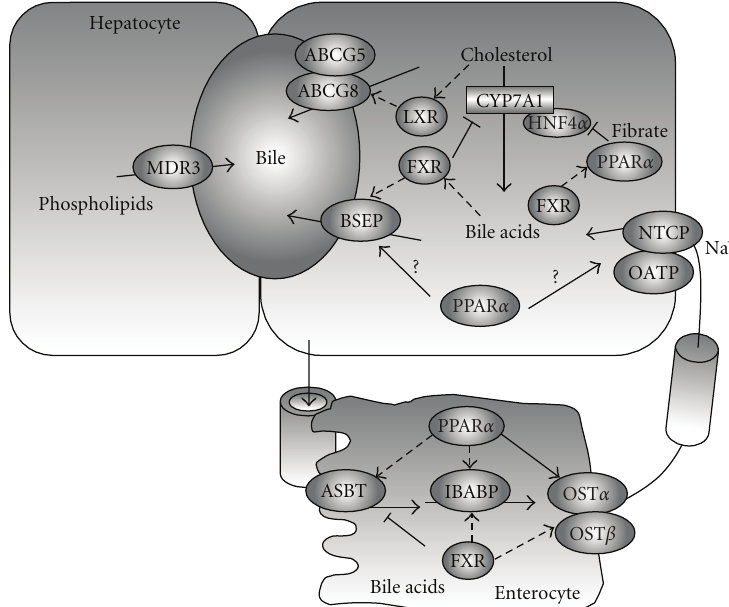
Figure 2: Enterohepatic circulation of bile. Bile acids are transported across the canalicular membrane of hepatocytes by BSEP. Cholesterol is either converted into bile acids for biliary secretion or transported by ABCG5/G8 into the bile. MDR3 mediates biliary phospolipids secretion. Cholesterol, bile acids and phospholipids form mixed micelles to solublize cholesterol and reduce bile acid cytotoxicity. After food intake, gallbladder contracts and releases bile acids into intestine. Approximately 95% of bile acids are reabsorbed into the enterocytes. OST α /OST β heterodimeric transporter mediates basolateral bile acid e ffl ux into the portal circulation. NTCP and OATPs mediate hepatic basolateral uptake of bile acids, which are then resecreted into the bile. In the hepatocytes, bile acid-activated FXR feedback inhibits CYP7A1 and NTCP, and thus bile acid synthesis and uptake. Bile acid-activated feed-forward stimulates BSEP and biliary bile acid secretion. Cholesterol derivatives oxysterols activate LXR, which induces ABCG5/G8 and biliary cholesterol secretion. In the intestine, FXR inhibits ASBT and stimulates IBABP and OST α and OST β